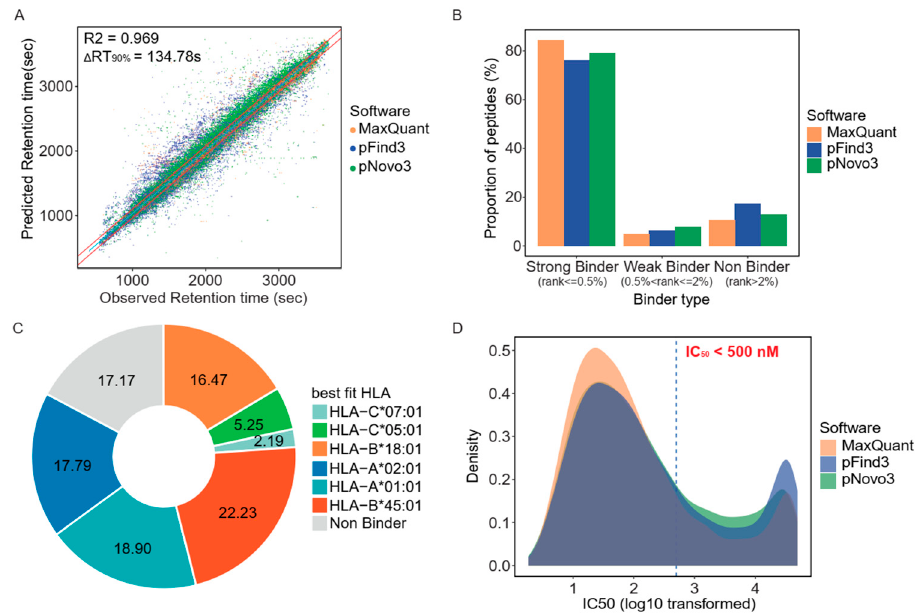
Figure 2. Common features of human leukocyte antigen (HLA)-I-presented peptides of the HC116 cell line: ( A ) Comparison of measured versus predicted retention times of HLA-I-presented peptides showed high correlation (Pearson R 2 = 0.969). Solid red lines mark the difference between measured and predicted retention times encompassing 90% of all peptides. Solid blue line indicates the fitted linear regression line; ( B ) Proportion of peptides identified by the three items of software under different binder levels. (%Rank ≤ 0.5% for Strong Binder, %Rank > 0.5% and ≤ 2% for Weak Binder, %Rank > 2% for Non Binder)”; ( C ) Distribution of the proportions of peptides with predicted affinity for specific HLA alleles; and ( D ) Distribution of the dissociation constant (IC 50 ) predicted by